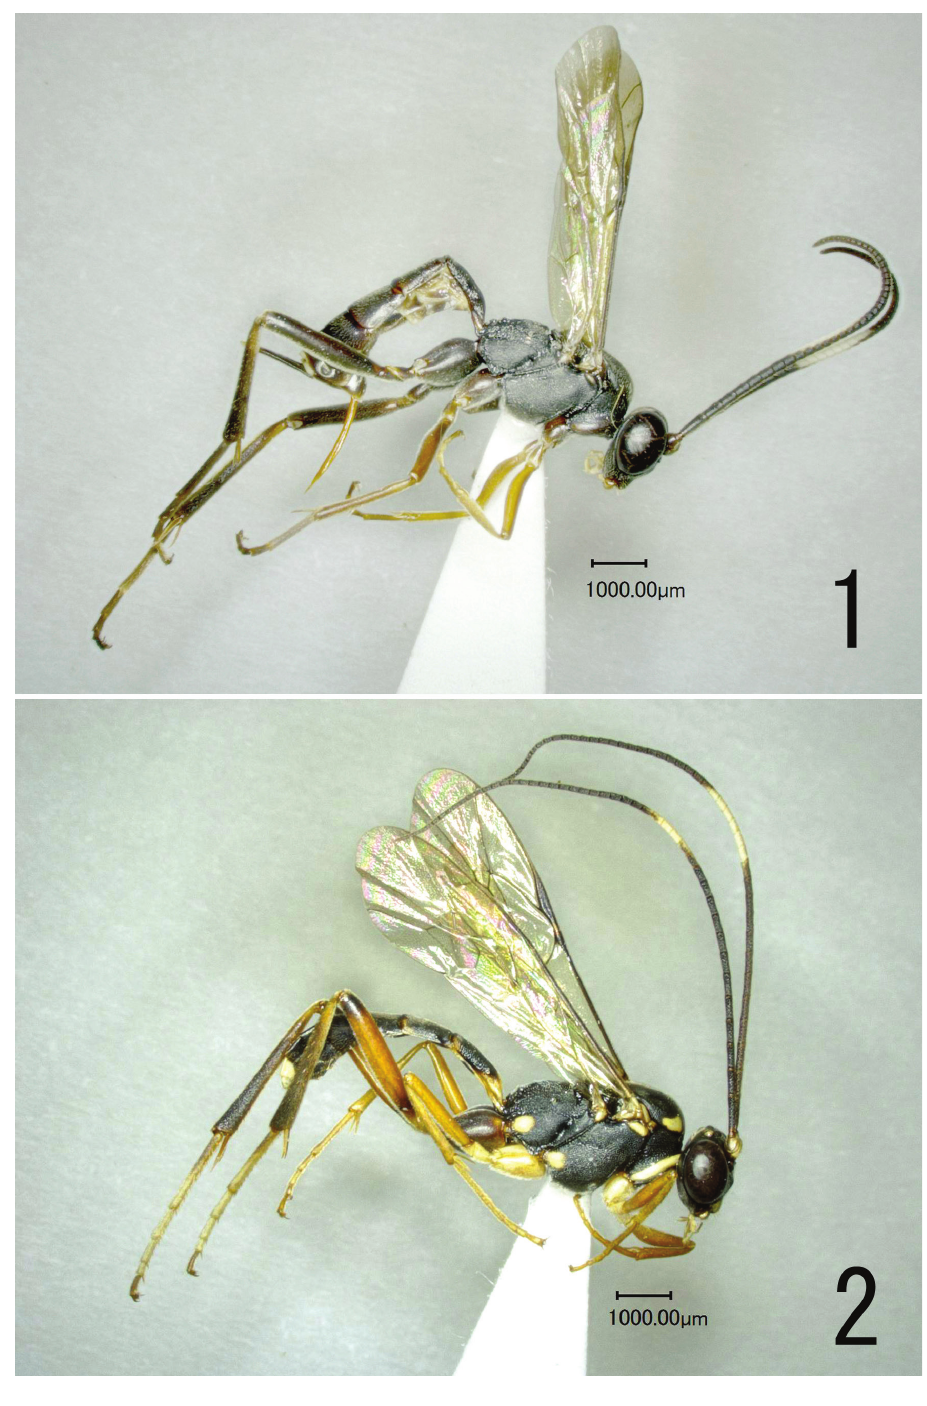
Figures 1, 2. Lateral habitus of C. sulawesiensis sp. n. 1 Female (holotype) 2 male